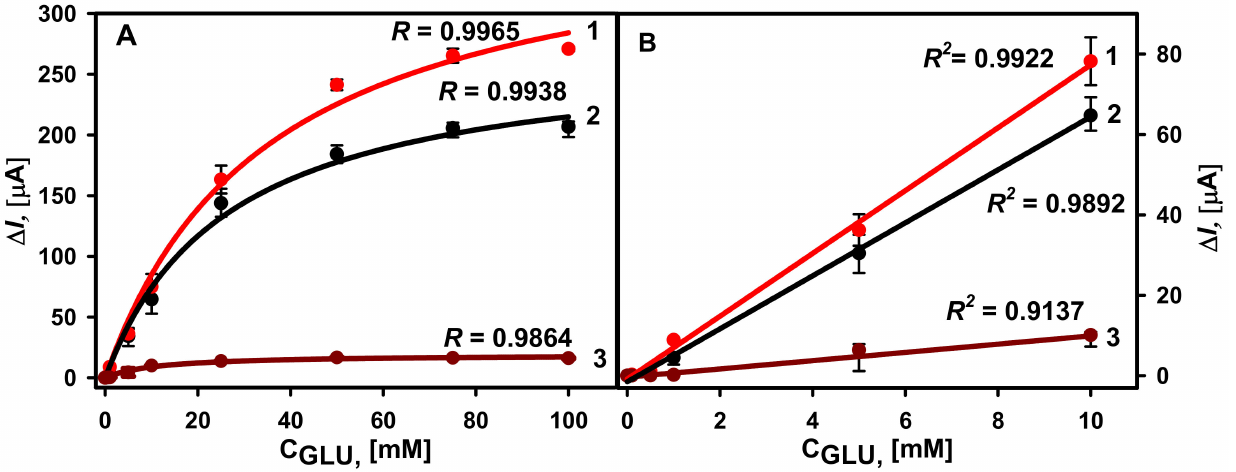
Figure 4. ( A ) Calibration plots of glucose biosensors based on GA-GOx-SAM/DGNs/GR (curve 1, third GOx immobilization method, red dots • ), GA-GOx/DGNs/GR (curve 2, first GOx im- mobilization method, black dots • ), and GOx-SAM/DGNs/GR electrodes (curve 3, second GOx immobilization method, brown dots • ). ( B ) The linear dynamic ranges of the developed biosensors. The amperometric response at +0.3 V was registered in 0.05 M SA buffer with 0.1 M KCl (pH 6.0) in the presence of 6.0 mM